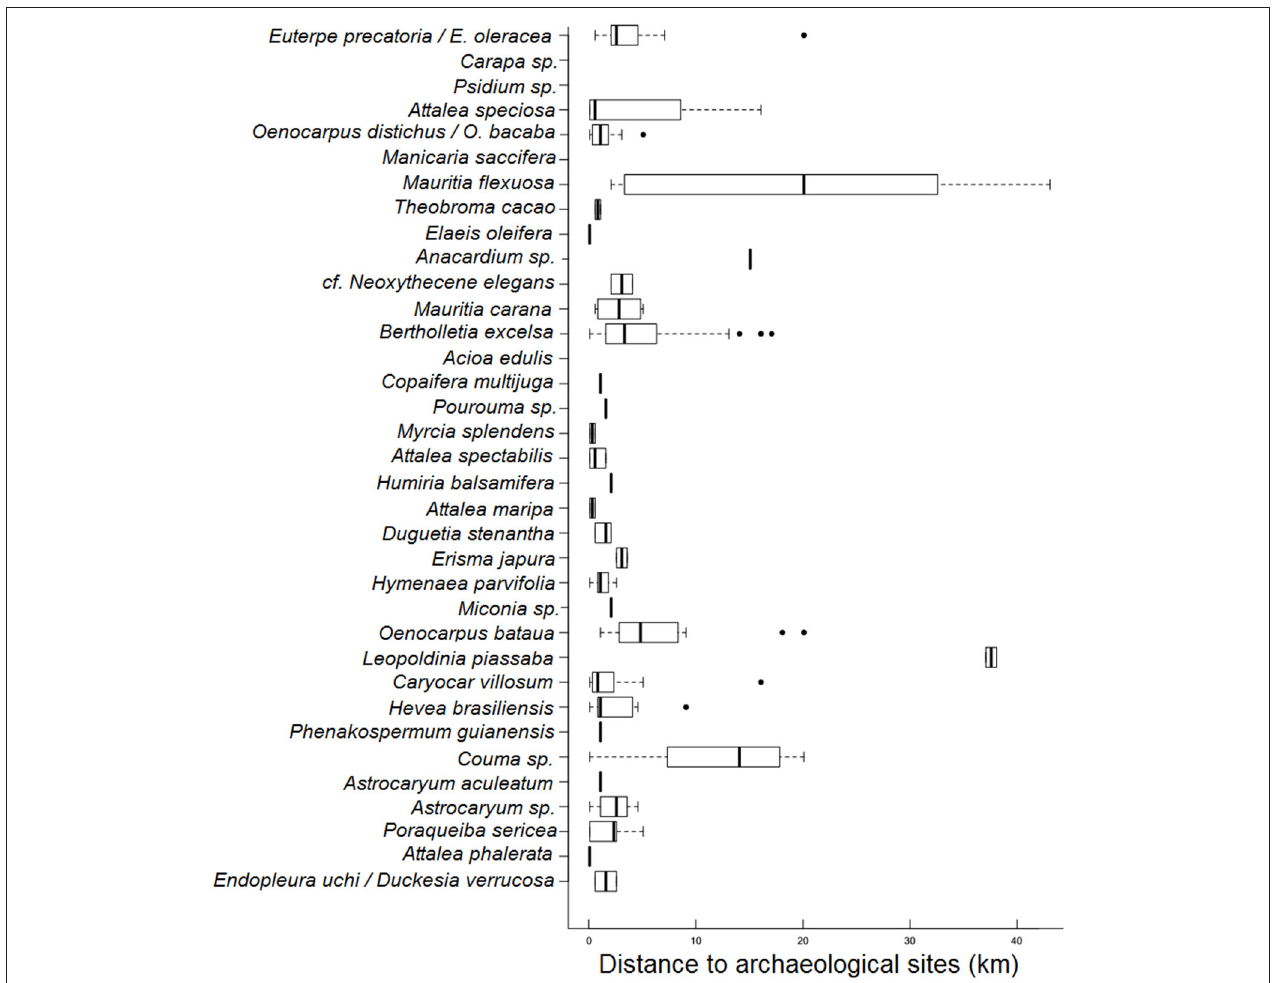
FIGURE 5 | Occurrences of patches of useful species along a distance gradient from archaeological sites. Median (dark line), first and third quartile (rectangles), minimum and maximum distances (dotted line) from the forest patches to the closest archaeological site are presented. Archaeological sites are ancient sedentary settlements with anthropogenic soils (TPI) and have been re-occupied by contemporary peoples. Black dots are extreme values (outliers). No data is available for three species because people couldn’t determine the location of these patches in the maps we